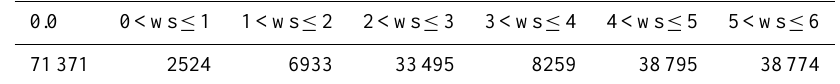
Table 3. Count of observed wind speeds (ws) by wind speed (in knots) for the 2012